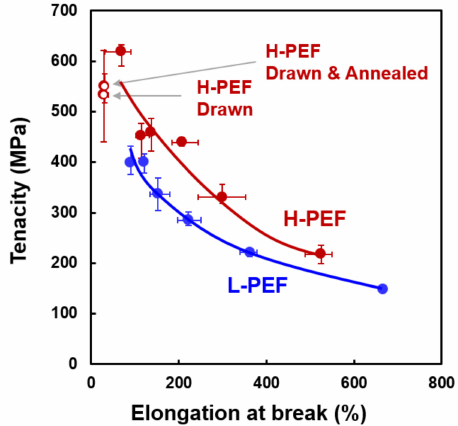
Figure 10. Relation between tenacity and elongation at break for high-speed spun L-PEF and H-PEF fibers. Data for drawn fiber and drawn and annealed fiber are also shown for